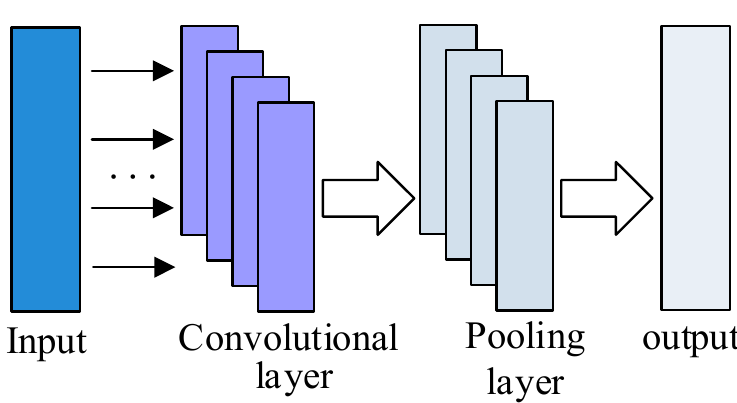
Figure 3. Typical structure diagram of convolutional neural network.